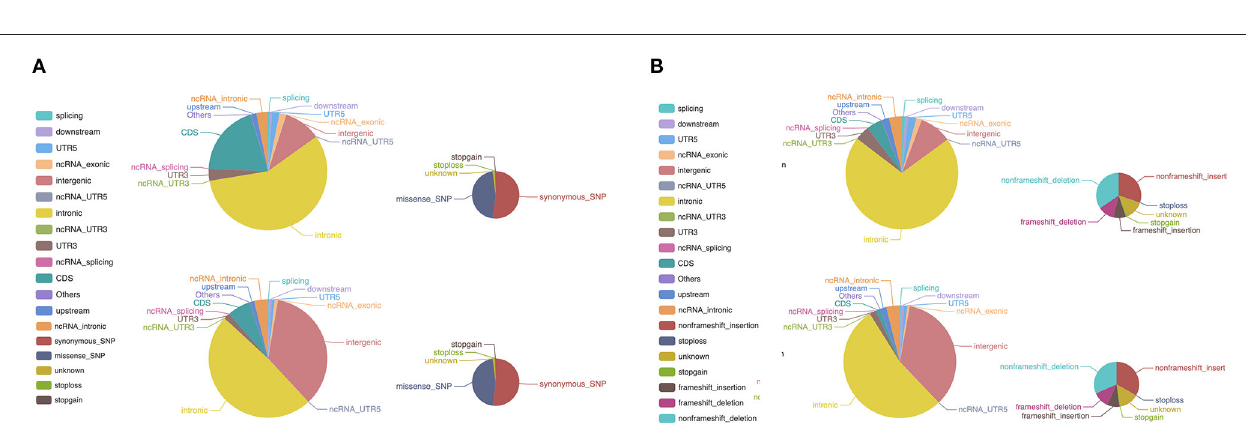
FIGURE 3 | WES of the patient tumor sample and peripheral blood lymphocyte sample. (A) Differences in the distribution of SNPs between the tumor sample and peripheral blood lymphocyte sample. The larger pie charts represent the genome, and the smaller ones the CDS. (B) A similar pattern was observed in the distribution of InDels between the tumor sample and peripheral blood lymphocyte sample. The larger pie charts represent the genome, and the smaller ones the CDS. WES, whole-exome sequencing; SNP, single nucleotide polymorphism; CDS, coding sequence; InDels, insertions and